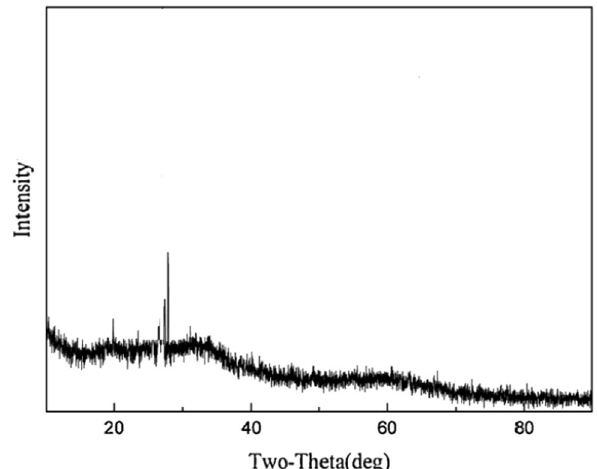
Fig. 6 XRD curve for